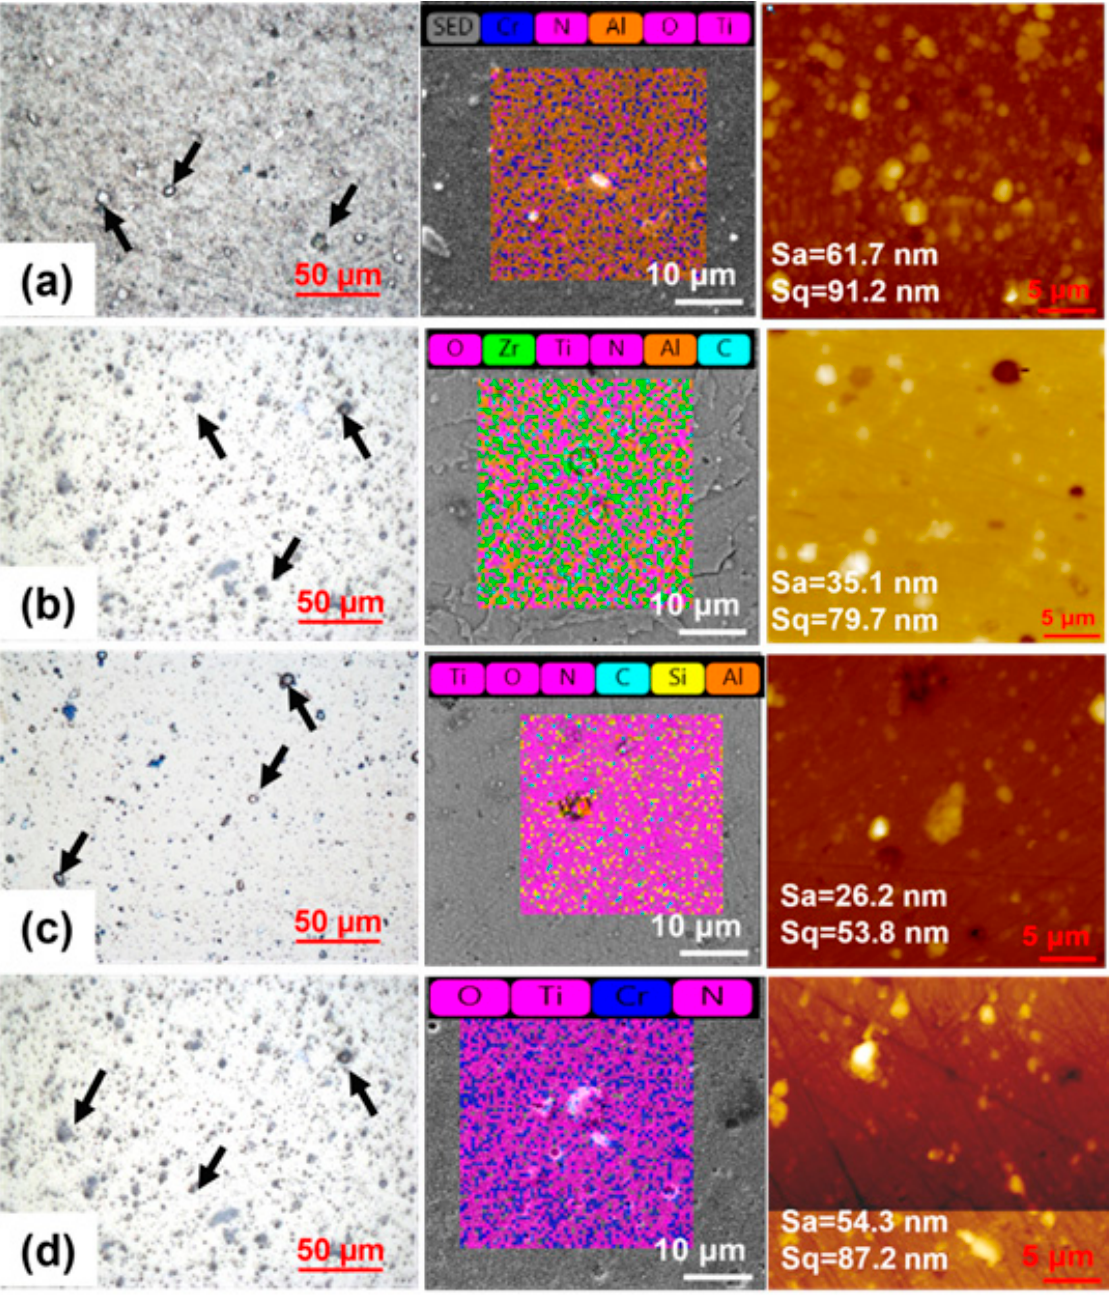
Figure 3. Optical microscope, AFM, and SEM/EDX analysis of ( a ) coating A, ( b ) coating B, ( c ) coating C, and ( d ) coating D; droplets are marked by arrows.